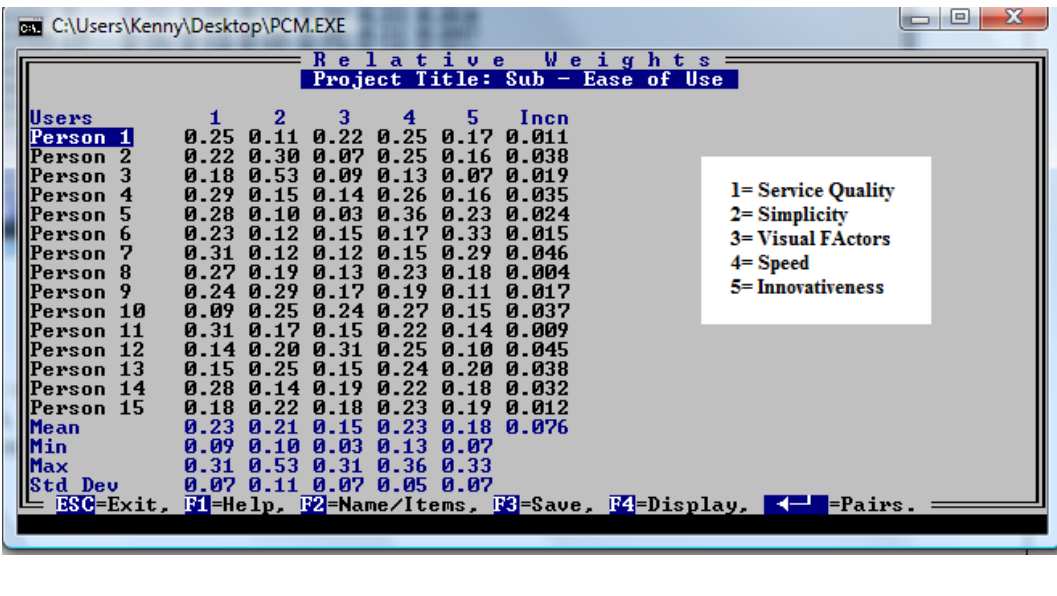
Figure 4. “Sub Criteria – Ease of